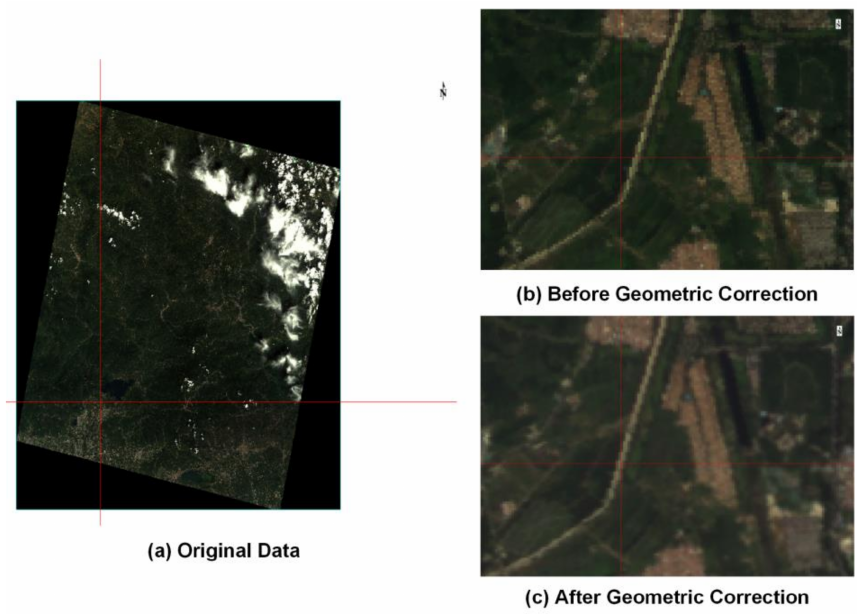
Figure 8. Comparison of vegetation spectral curves before and after atmospheric correction in the study area.